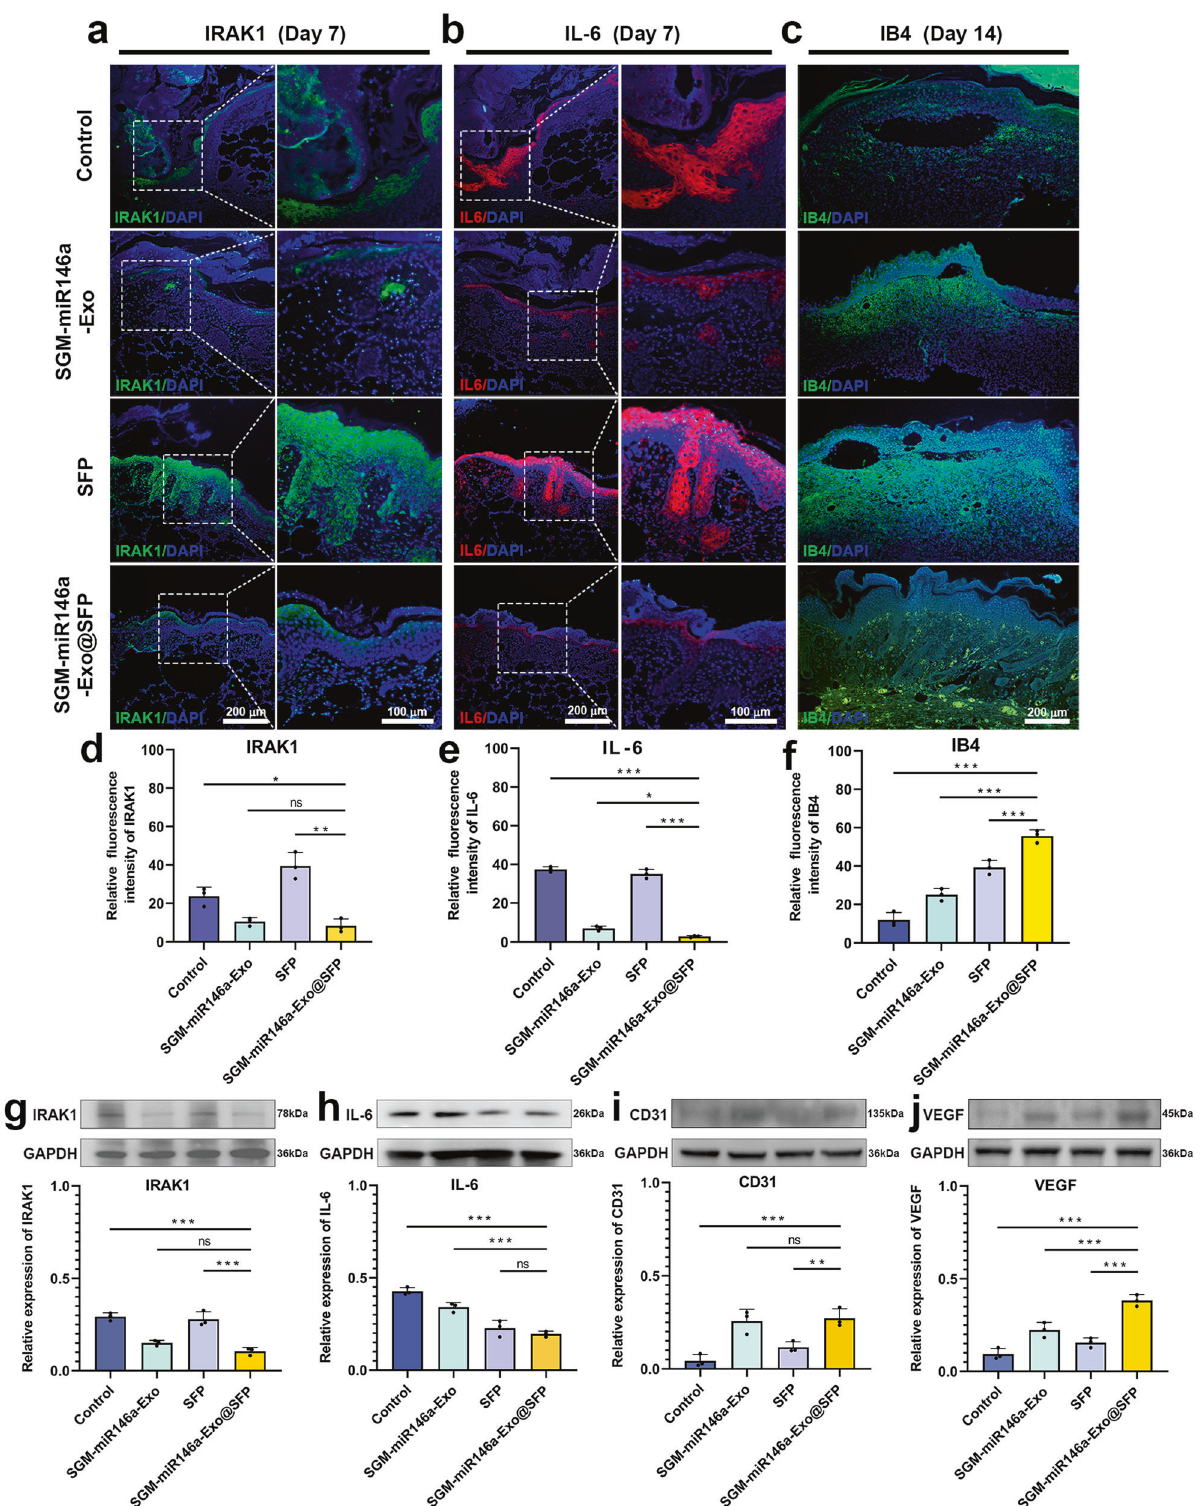
Fig. 7 SGM-miR146a-Exo@SFP attenuated in fl ammation and increased neovascularization of diabetic wounds. a – c Immuno fl uorescence of IRAK1, IL-6, and IB4 of the wound tissue (scale bar: 200 μ m). d – f Statistical analyses of IRAK1, IL-6, and IB4 immuno fl uorescence. g The IRAK1 expression was decreased in SGM-miR146a-Exo@SFP group. h The IL-6 expression was decreased in SGM-miR146a-Exo@SFP group. i The increased CD31 expression in SGM-miR146a-Exo@SFP group. j The increased VEGF expression in SGM-miR146a-Exo@SFP group. Data represent the mean ± S.D. of three different experiments (ns: no signi fi cance, * p < 0.05, ** p < 0.01, *** p <